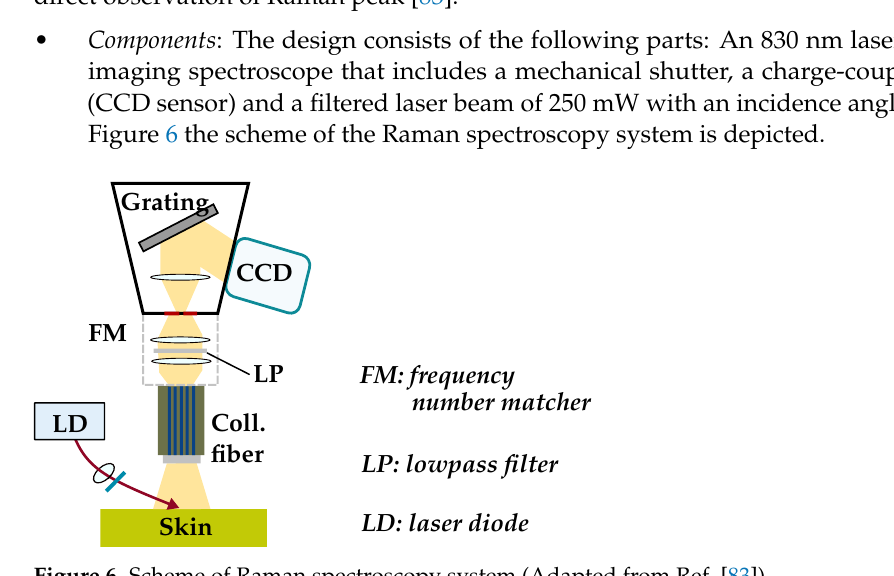
Figure 6. Scheme of Raman spectroscopy system (Adapted from Ref.